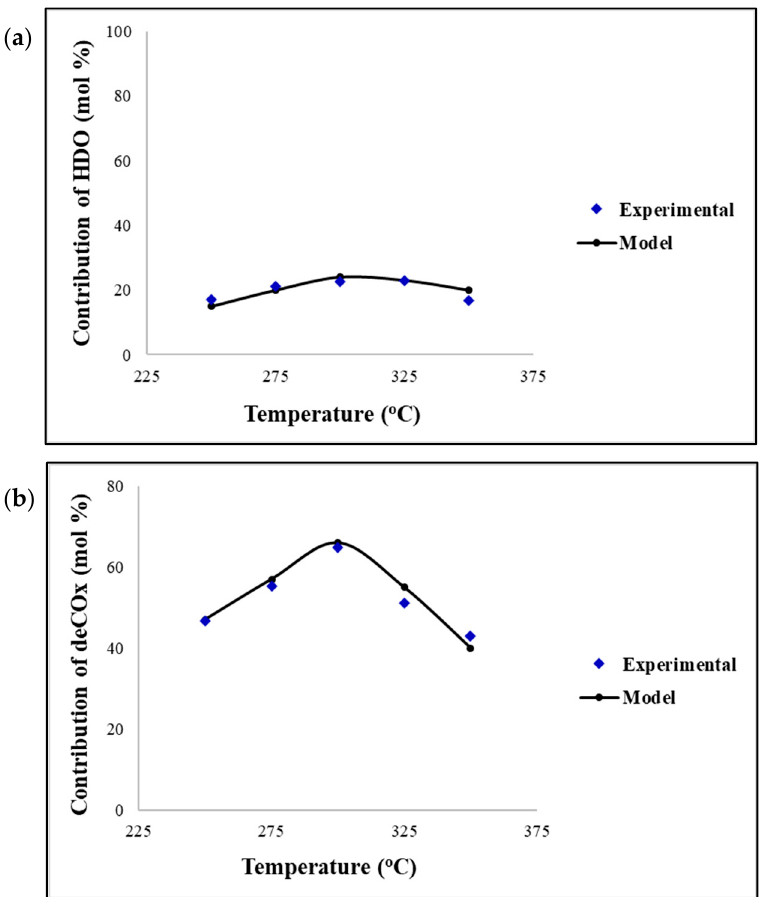
Figure 2. Contribution of the ( a ) HDO reactions and ( b ) deCO x reactions against reaction temperature. Reaction conditions: pressure = 30 bar, H 2 /oil ratio = 1000 and inlet liquid flow = 0.1 mL/min.